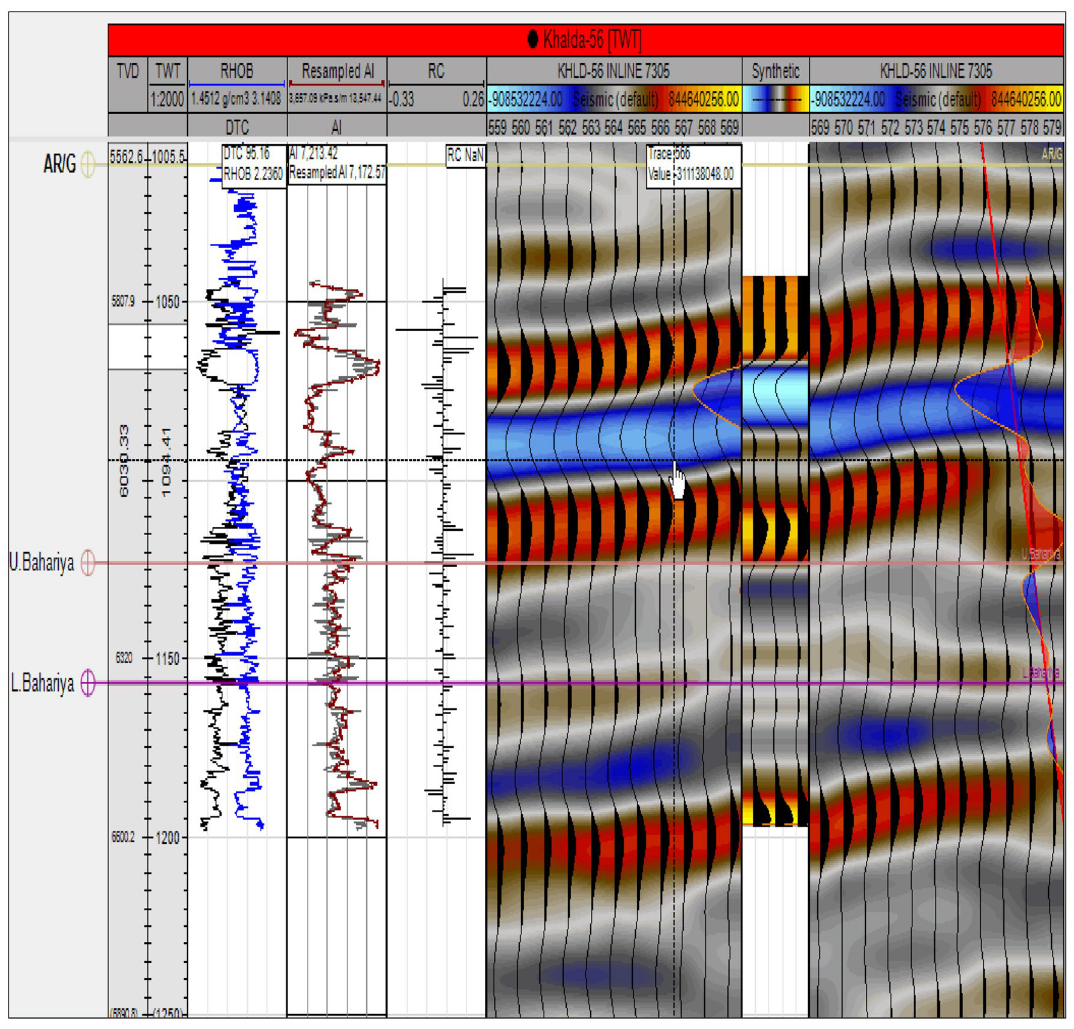
Fig. 9 A synthetic seismogram created for the Khalda-56